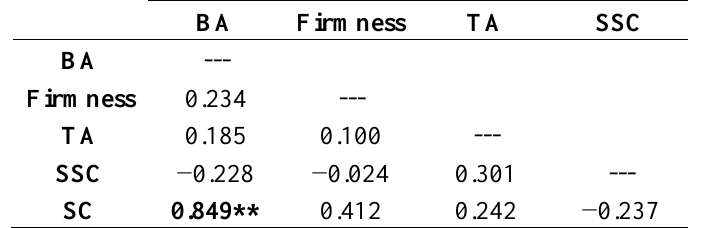
Table 2. Pearsons’ correlation coefficient matrix between variables measured in this study for seven apple cultivars. BA—biospeckle activity, TA—titratable acids, SSC—soluble solids content, SC—starch content.